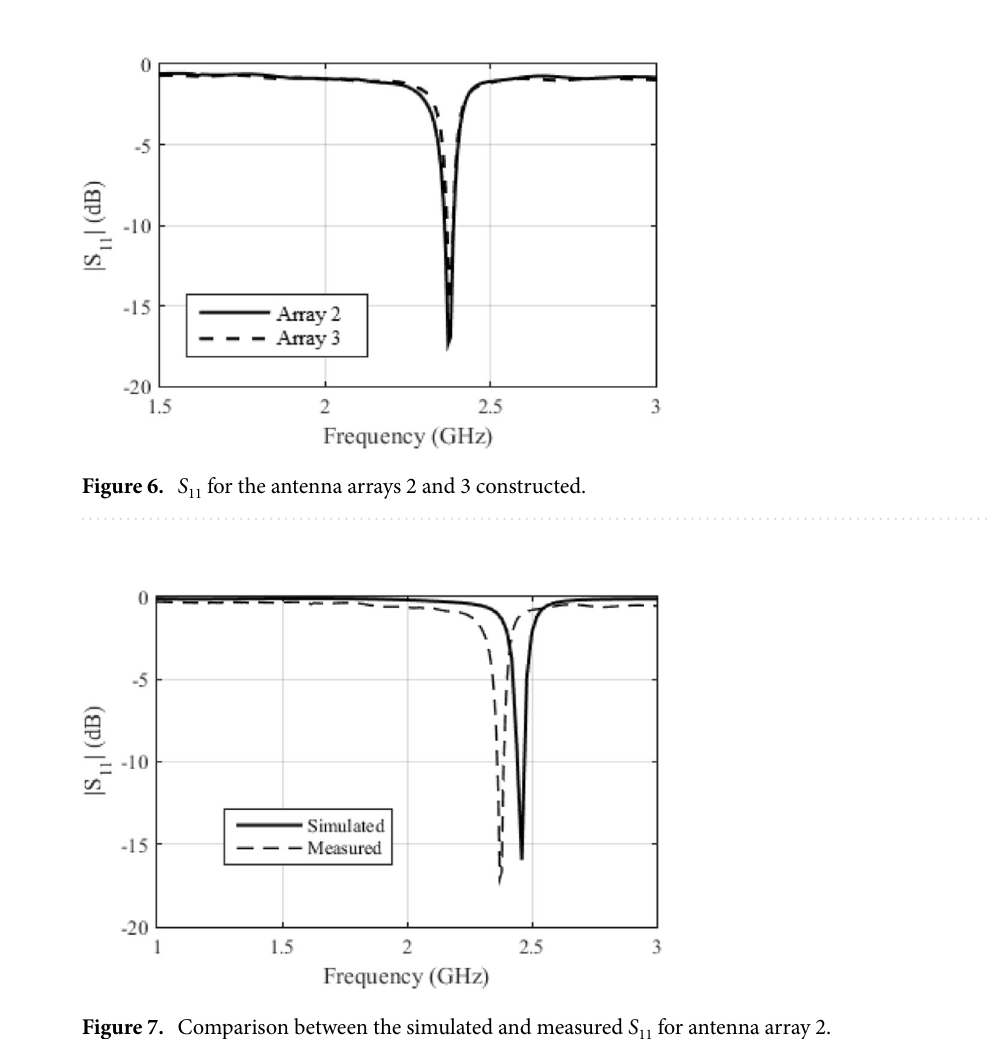
Figure 5. S 11 measure for the four constructed antenna arrays.